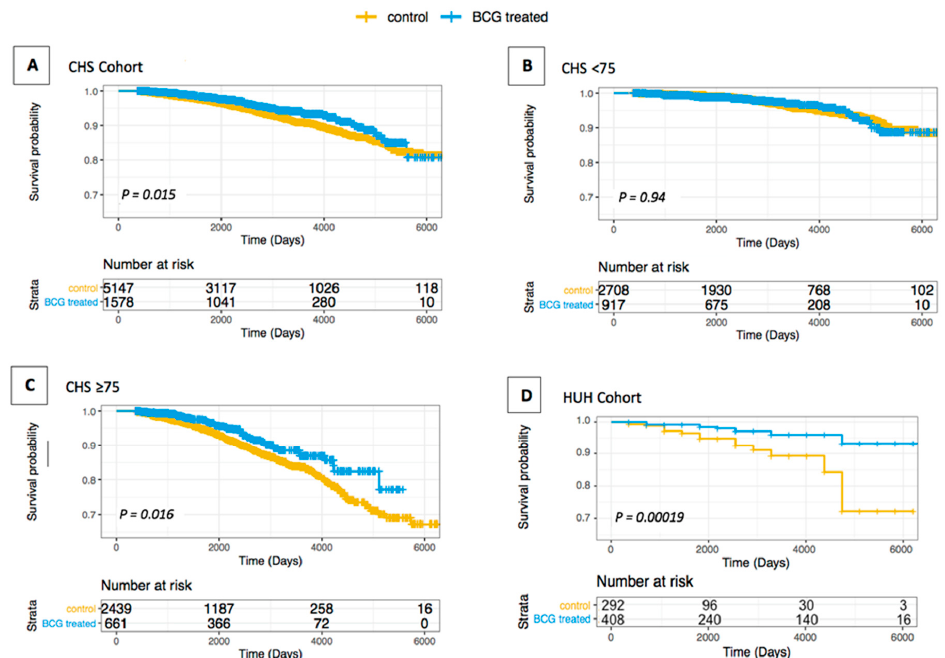
Figure 1. Kaplan–Meier survival curves of AD-free bladder cancer patients treated or not treated with BCG. The whiskers on the Kaplan–Meier (KM) survival plots represent the censored patients. ( A ) CHS cohort; ( B ) CHS < 75 years old; ( C ) CHS ≥ 75 years old; ( D ) HUH Table 3. Risk assessment of AD in CHS and HUH cohorts by Kaplan–Meier (KM), Cox proportional hazards regression (Cox), and competing risk analysis (CR).